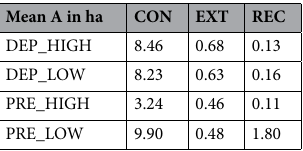
Table 4. Mean area of patches among persistence categories.